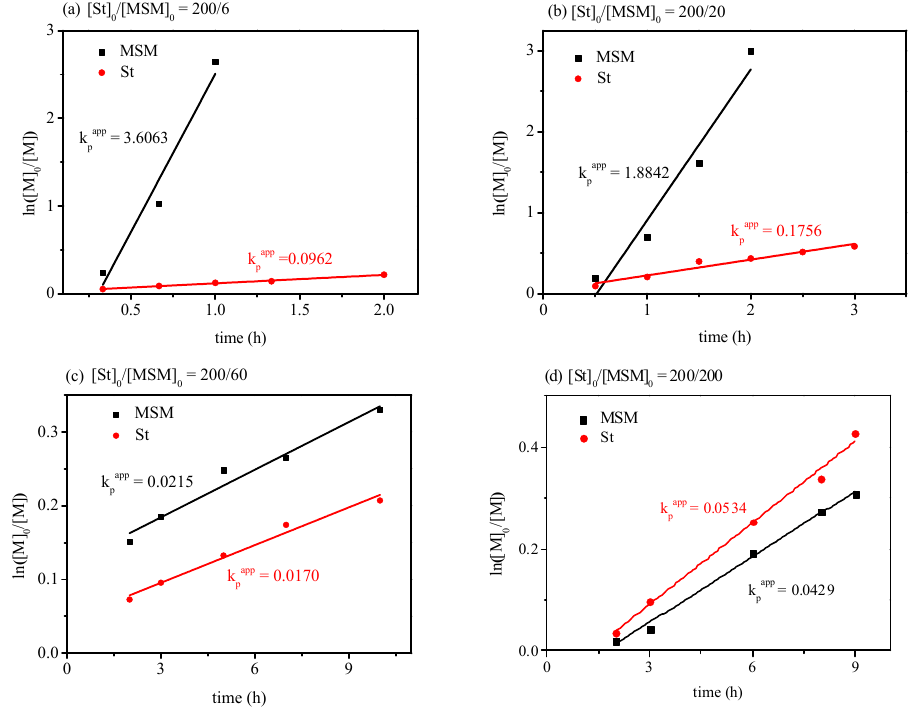
Figure 1. Kinetic plots of reversible addition-fragmentation chain transfer (RAFT) copolymerization of St and MSM with different molar ratios, ( a ) [St] 0 /[MSM] 0 = 200/6; ( b ) [St] 0 /[MSM] 0 = 200/20;